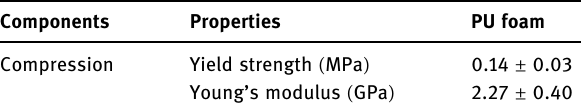
Table 3: Material properties of foam